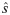
Effect of symmetry s^ on system dynamics.(A): Standard plot of fλ>0 as a function of balance and density, for constant symmetry s^=0. (B): Plot of fλ>0 as a function of balance and symmetry, for constant density d^=0.5 (see orange box in (A)). (C): Plot of fλ>0 as a function of symmetry and density, for constant balance b^=0 (see green box in (A)). For too large symmetry s^≈1, the system ends up in fixed point attractors, irrespective of balance and density. Note that the phase diagram shown in (A) is the same as shown in Fig 3D.